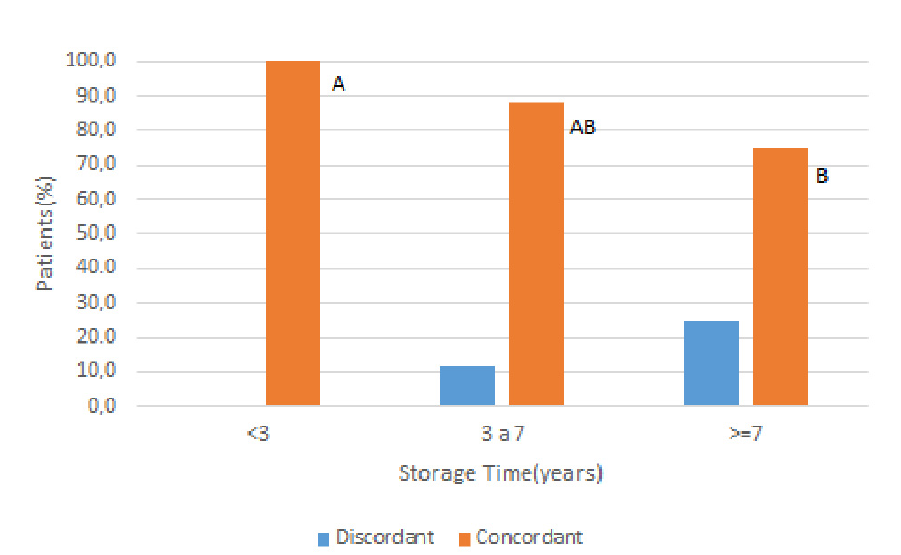
Figure 2. Evaluation of 180 paracoccidioidomycosis patients according to the percentual of concordant titers of anti- P. brasiliensis serum levels determined by the double agar gel immunodiffusion test and time of storage at –80 o C. Goodman test ( p = 0.003). Titers are considered concordant if the difference between test and retest is of only one dilution. Frequencies followed by the same letter do not differ among them ( p > 0.05), while those followed by different letters present statistically significant differences ( p ≤ 0